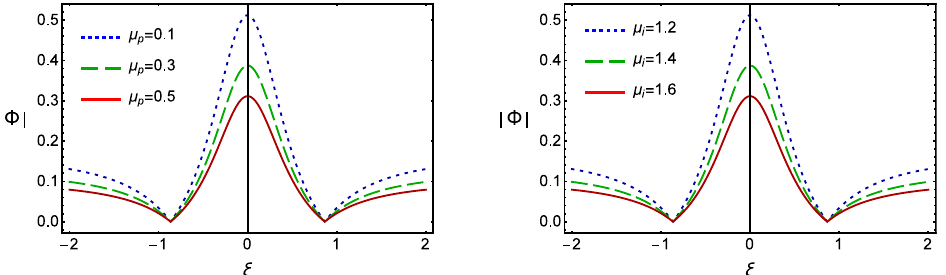
Figure 2. Plot of | φ | versus ξ for different values of µ p and µ i = 1.4 ( left panel), and plot of | φ | versus ξ for different values of µ i and µ p = 0.3 ( right panel) when α = 1.0, δ = 0.0003, q = 1.5, and σ =